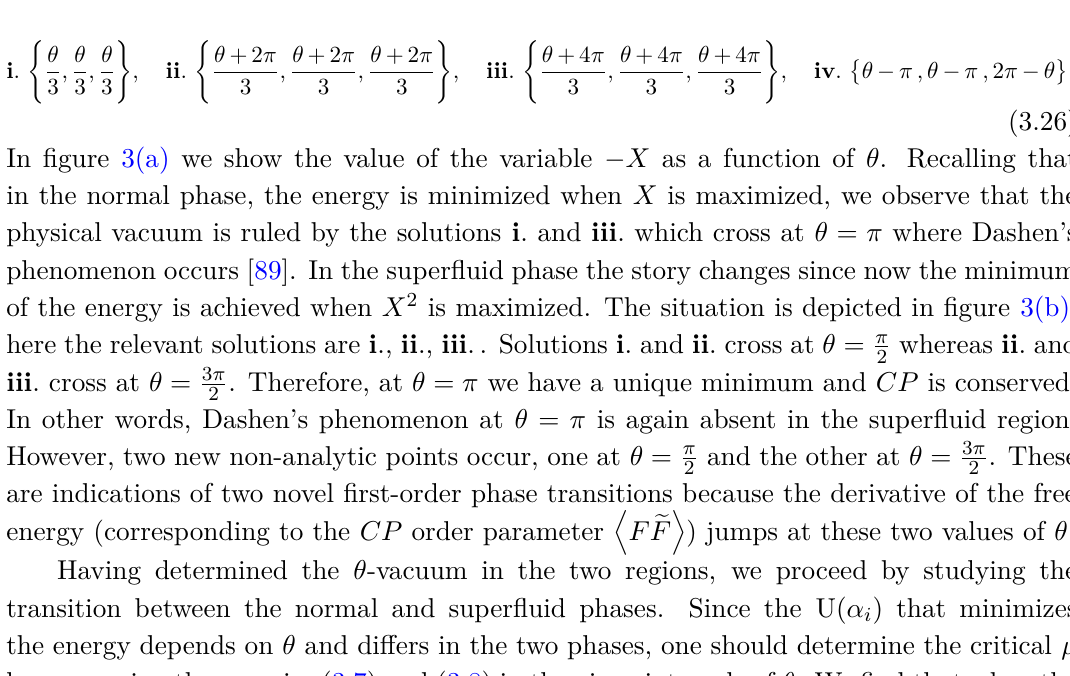
(a) CP order parameter for N mal phase. Figure 2 . CP order parameter as a function of θ both in the normal and superfluid phase for N = 2 f